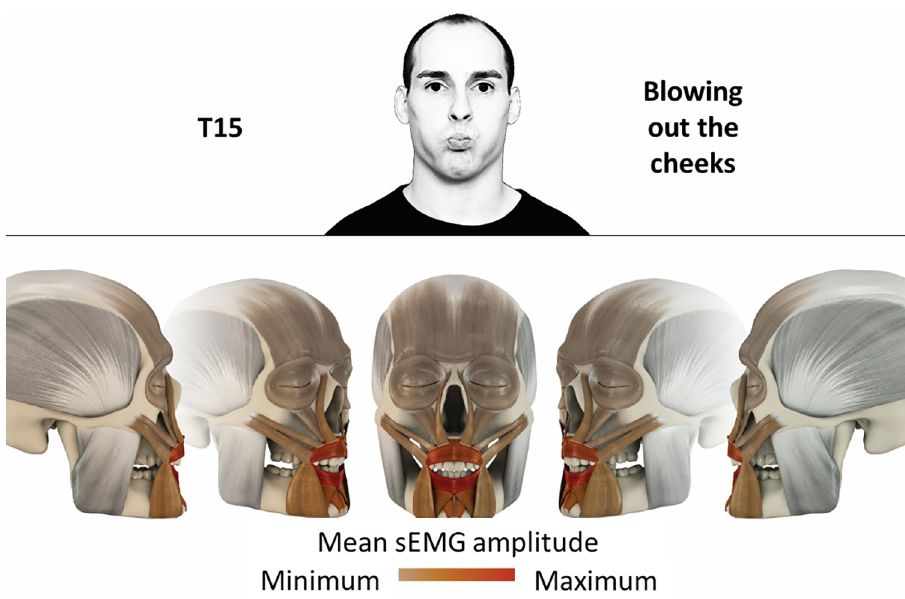
Fig 16. Color-coded facial muscle activation pattern of task T15. Blowing out cheeks. Animation by Jonas Laustro¨er.